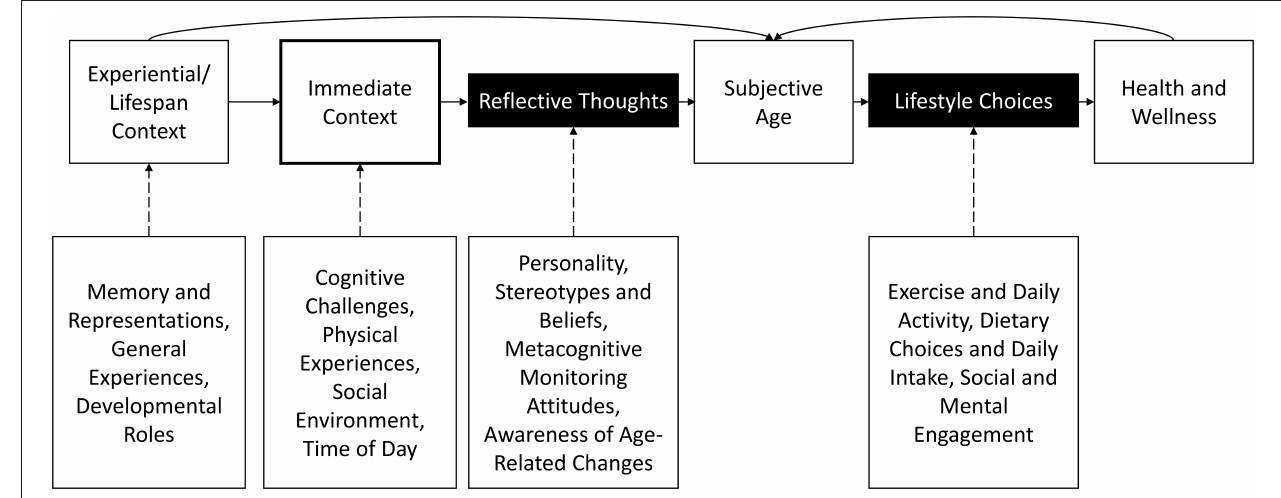
FIGURE 1 | Contextual model of subjective age. Subjective age is influenced by context through reflective